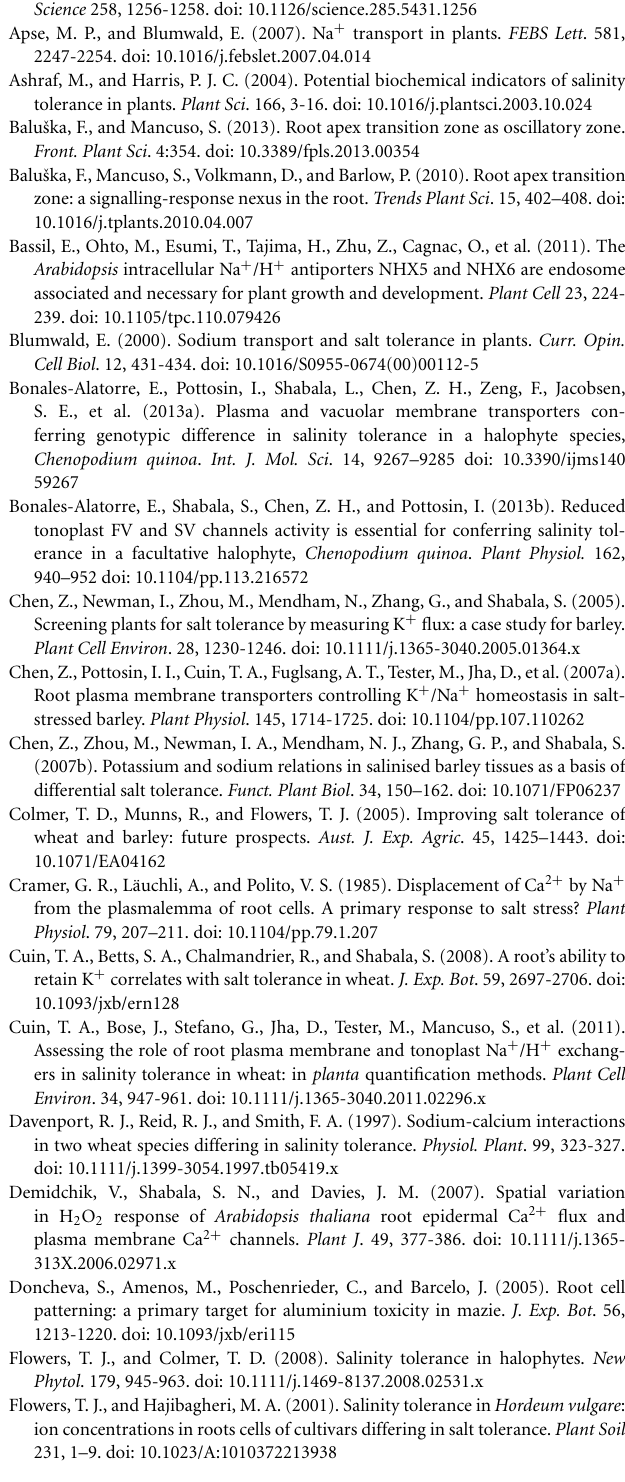
Supplementary Figure S4 | Correlation between salinity stress tolerance and Na + distribution in cytosol and vacuole in different root